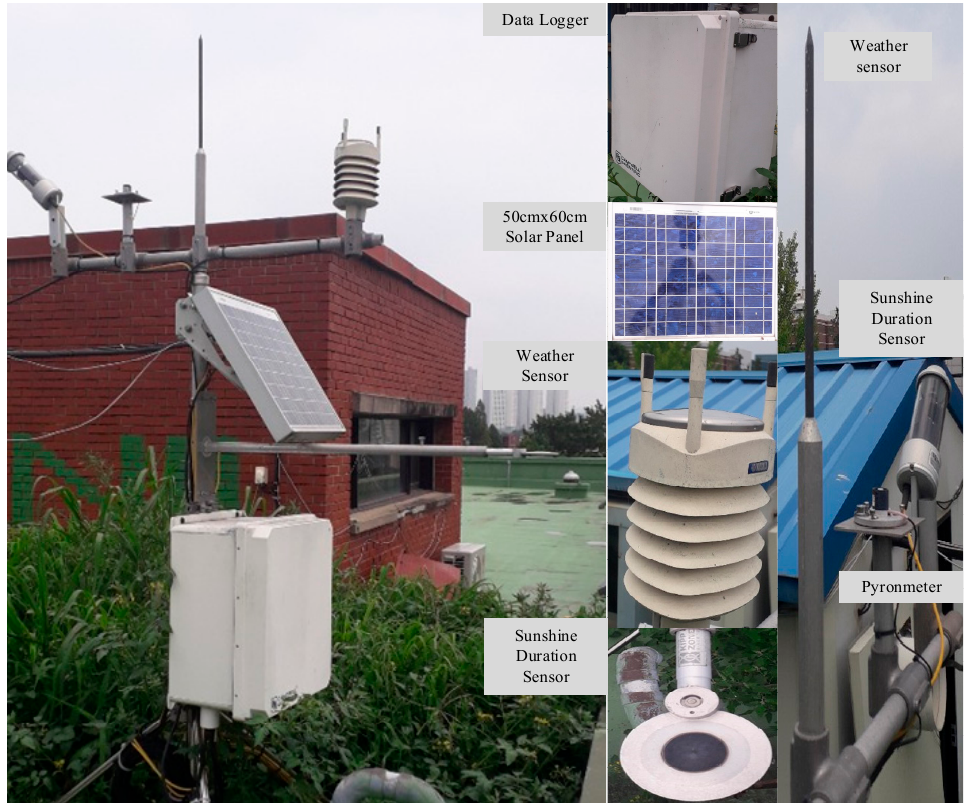
Figure 2. Various components of the weather station is shown in the pictures.